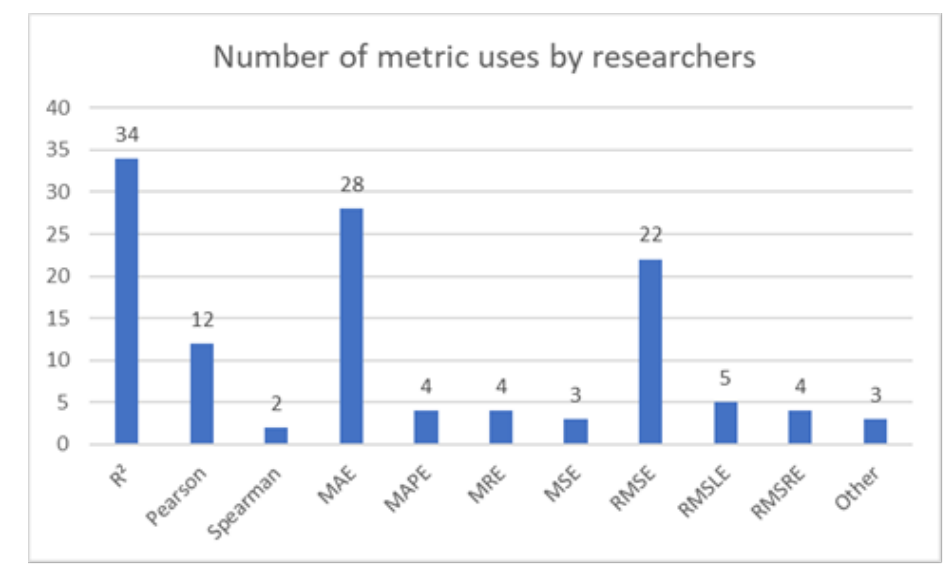
Figure 10. The number of metric uses within the reviewed papers. Abbreviations have been given in the text. Single-use metrics have been grouped into the “Other”